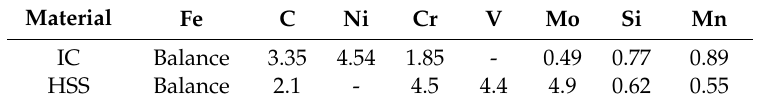
Table 1. Chemical compositions of the indefinite chill (IC) and high speed steel (HSS) materials (wt.%). Material Fe C Ni Cr V Mo Si Mn IC Balance 3.35 4.54 1.85 - 0.49 0.77 0.89 HSS Balance 2.1 - 4.5 4.4 4.9 0.62